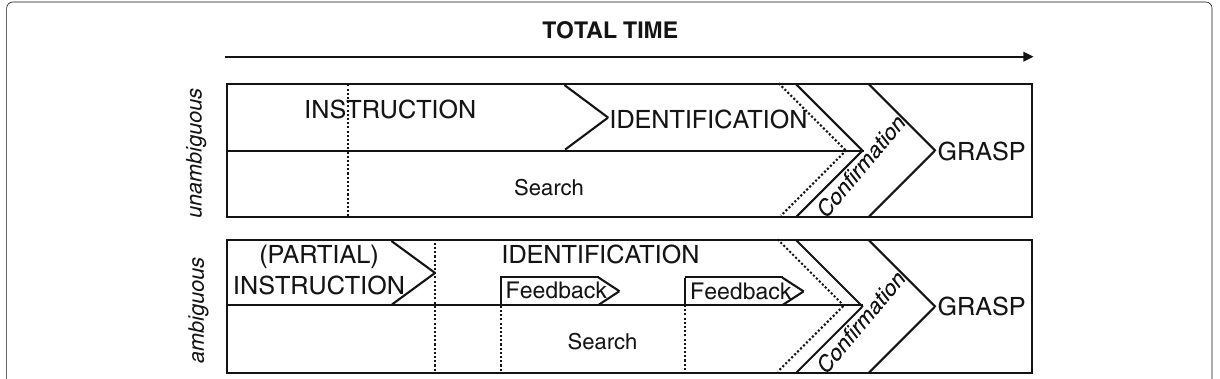
Fig. 3 Interaction phases for both strategies. The spoken instruction, followed by identification, i.e., time to first target inspection, and the grasp of the object after a verbal confirmation is given. The visual search starts either during or after instruction and can be interleaved with feedback, depending on the